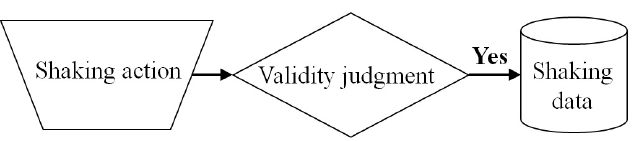
Figure 4. How to capture and save shaking data in our